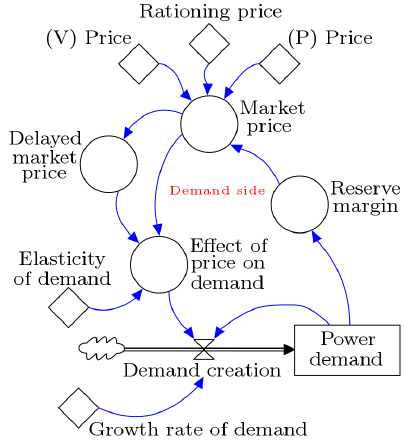
Figure 4. Demand component of the electricity system as in [13,14]. Reprinted with the permission of Reference [13]. Copyright 2018 Elsevier.